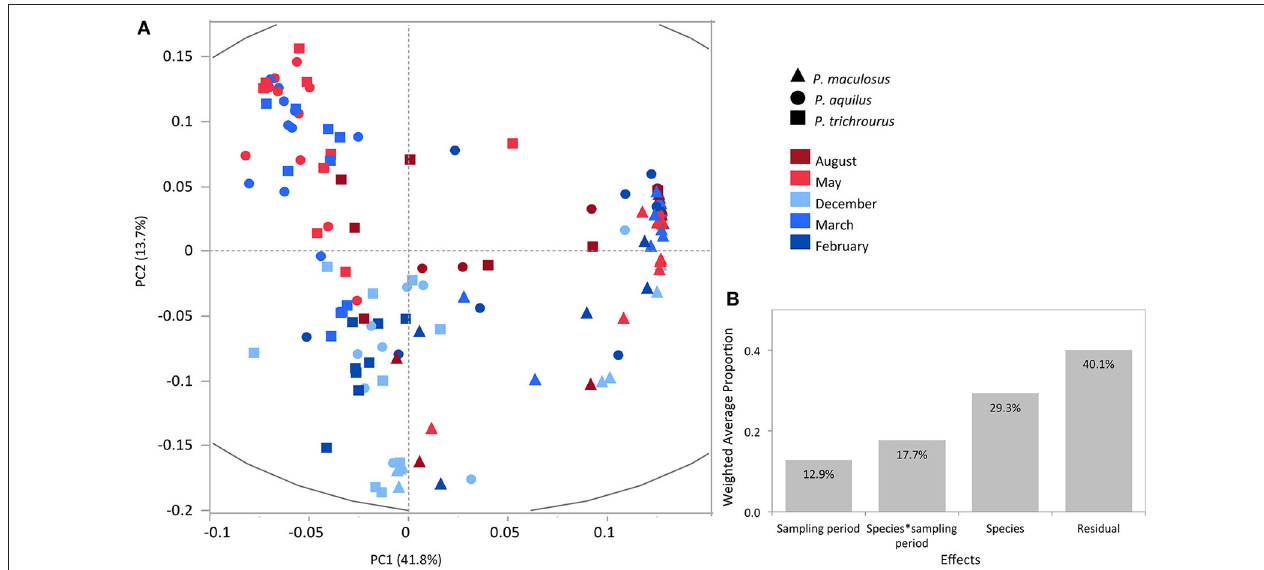
FIGURE 4 | Principal component (PC) and variance component (VC) analyses of the combined dataset. (A) PC1 and PC2 together explain 54.5% of the total variance. (B) VC analysis of PC1-3 for species, sampling period and the interaction between species and sampling